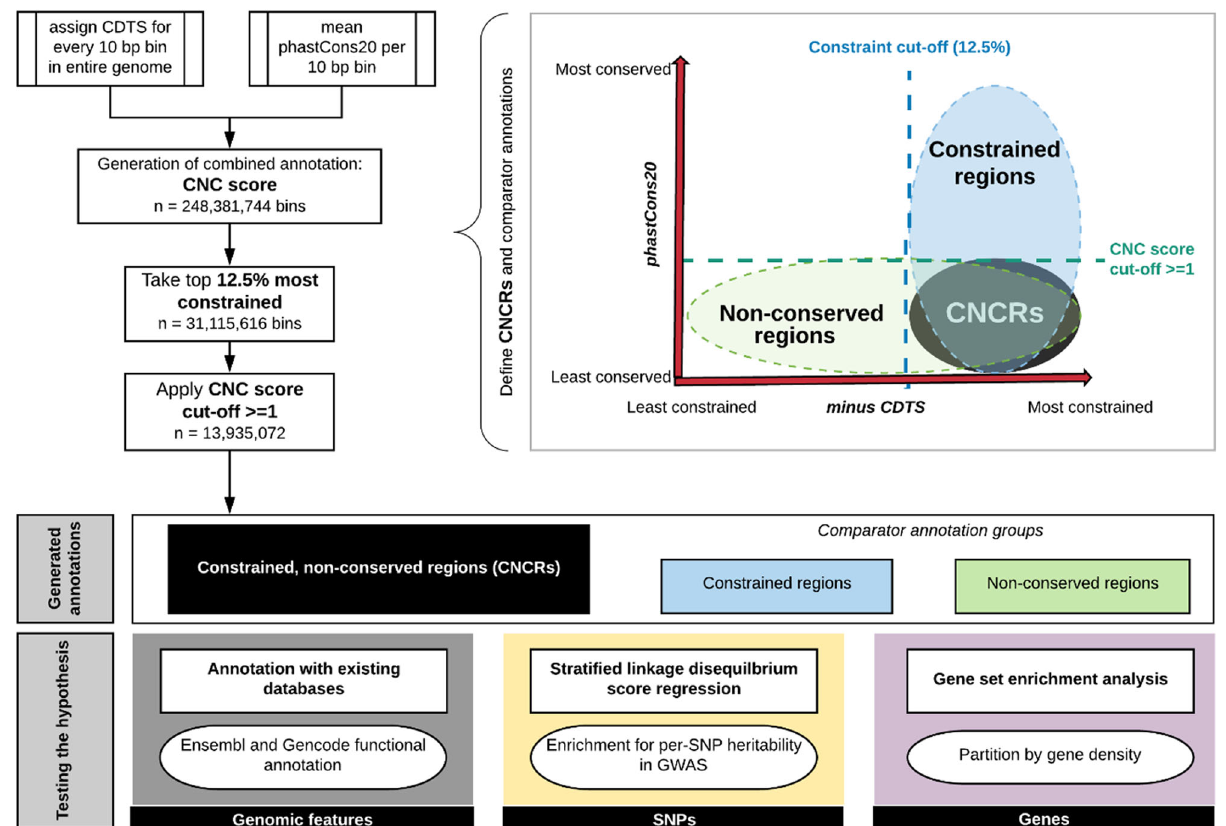
Fig. 1 Work fl ow of study and schematic demonstration of annotation groups. The work fl ow depicts the processes involved in creation of the annotation with set parameters for each of the three groups of annotations generated and the processes involved in hypothesis-testing. CNC scores: constrained, non- conserved scores; CNCRs: constrained, non-conserved regions: CNCRs are de fi ned as genomic regions that were fi rst among the 12.5% most constrained, then with a CNC score of ≥ 1 (i.e. a twofold higher ranking in constraint than conservation). Constrained regions are de fi ned as the regions within the 12.5% most constrained of the genome irrespective of conservation score. Non-conserved regions are de fi ned as relatively non-conserved genomic regions with a conservation rank determined by the rank of the fi rst quartile phastCons20 score at a CNC score of 1 (rank ≤ 25,623,592) (irrespective of constraint score). CDTS is the context-dependent tolerance score. Minus CDTS score is used as a lower score of CDTS corresponds to a more constrained